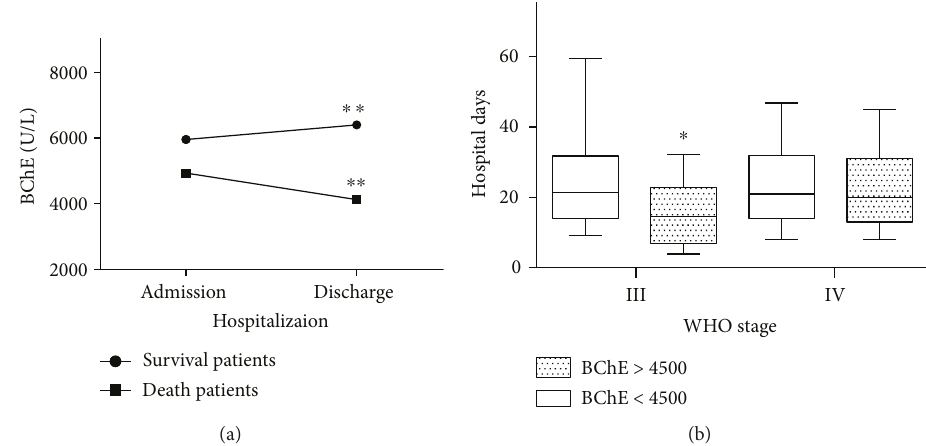
Figure 4: BChE level and hospitalization. (a) Mean BChE level increased from 5951.3 ± 2089.7U/L to 6399.1 ± 1960.5U/L ( P < 0 001 ) in patients who survived during the hospitalization, whereas, mean BChE level decreased from 4932.7 ± 2118.3U/L to 4122.9 ± 2009.1U/L ( P = 0 004 ) who died during hospitalization. (b) Patients with a low BChE have a longer duration of hospital stay than patients with a normal level of BChE at WHO stage 3 ( P = 0 010 ), but this trend is not obvious among patients at WHO stage IV. ∗ P < 0 05 , ∗∗ P < 0 01 using t -test.